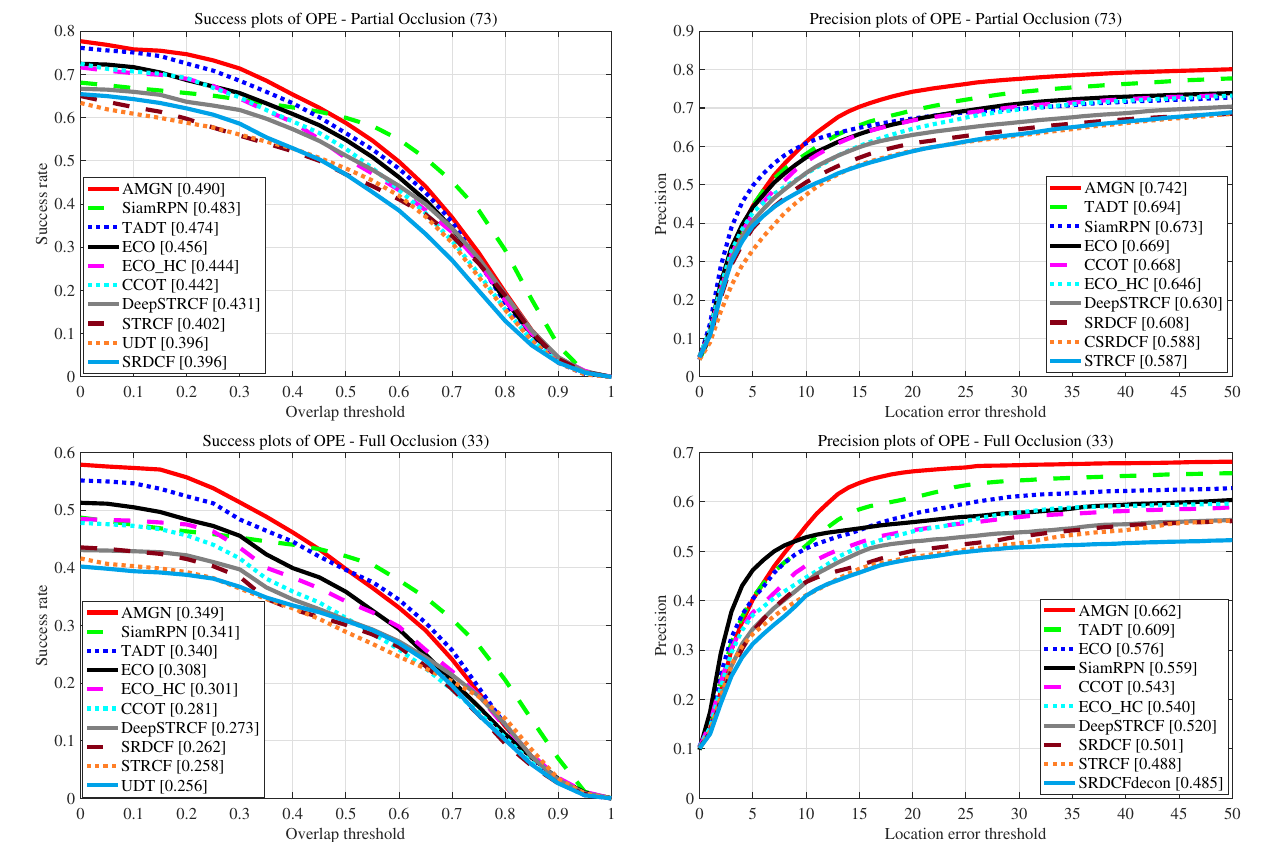
Figure 6. Success and precision plots on the UAV123 dataset using one-pass evaluation over tracking challenge occlusion.